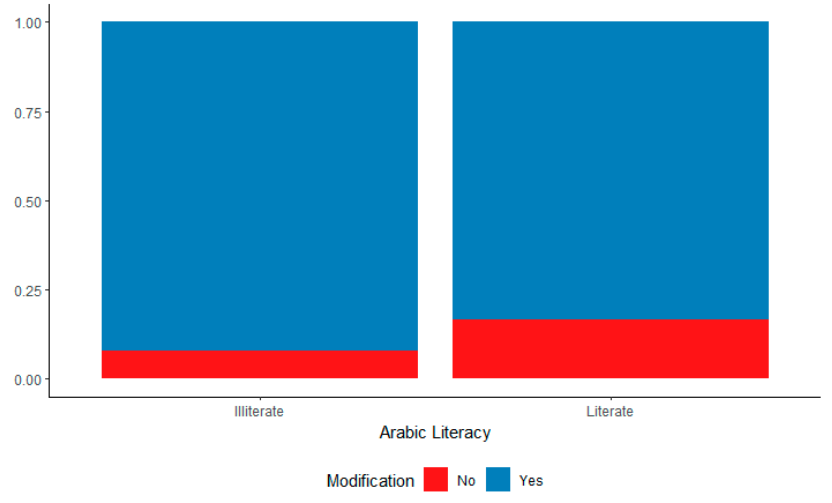
Figure 8. The percentages of target-like productions of Arabic onset consonant clusters by literate and non-literate FDHs.